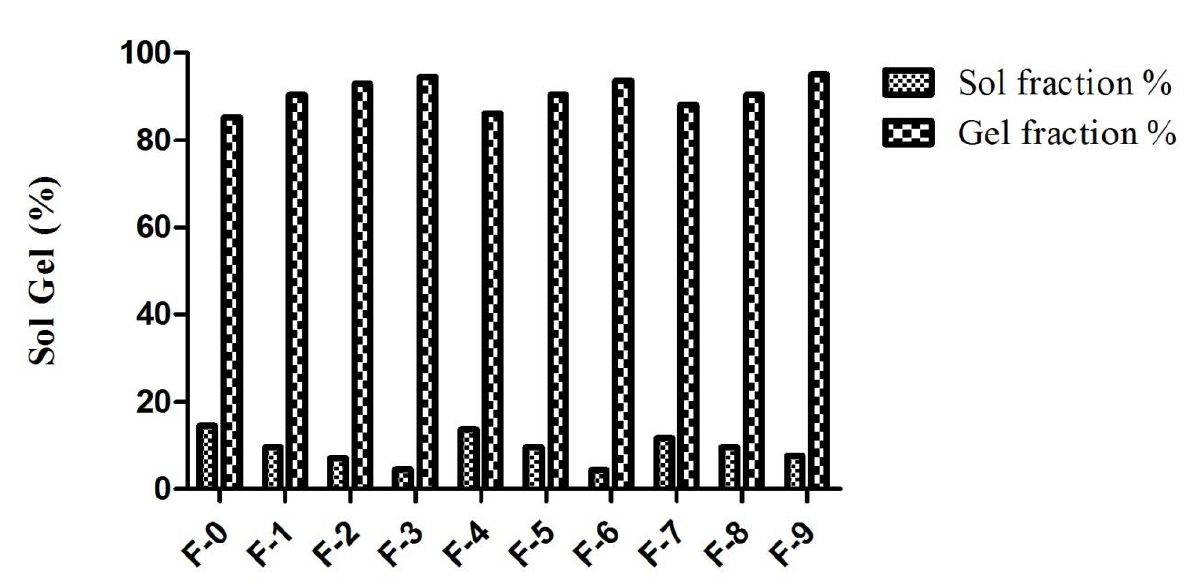
Figure 7. Sol-gel fraction of all synthesized